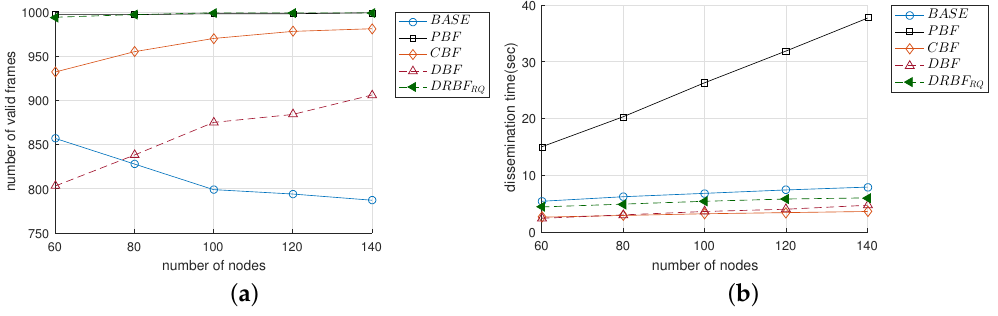
Figure 10. The performance comparison of the flooding mechanisms in terms of ( a ) the number of valid frames ( F val ) and ( b ) the dissemination time ( T dis ).